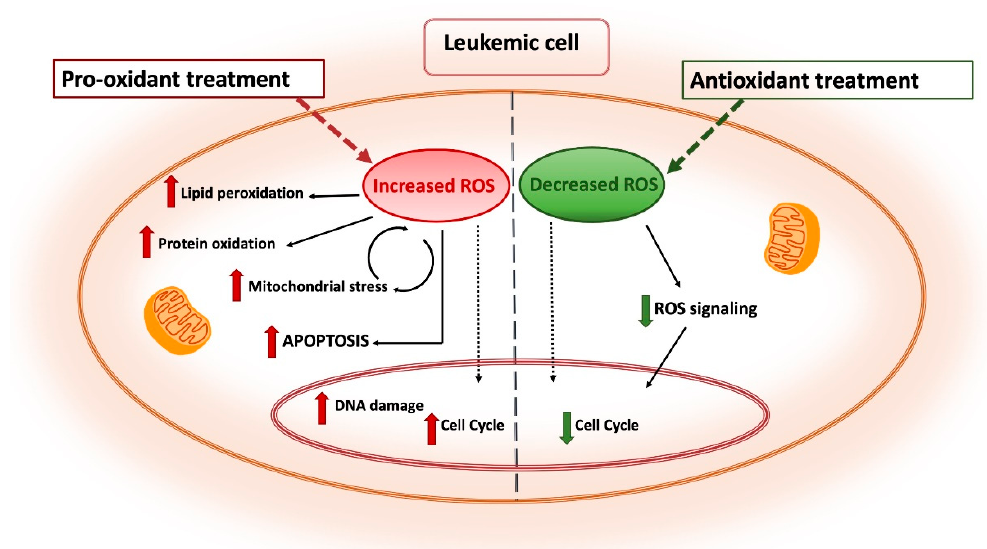
Figure 5. Antioxidant and pro-oxidant strategies as antileukemia therapeutic tools. Pro-oxidant treatments are designed as a strategy to overwhelm the redox adaptation of leukemia cells by inducing oxidative stress incompatible with cellular viability. Enhanced ROS production leads to lipid peroxidation, protein oxidation and DNA damage resulting in increased apoptosis. Conversely, antioxidant treatments are aimed to reduce the leukemogenic potential by tuning down cell proliferation and survival pathways in leukemia cells with high ROS levels. Distinct arrows indicate the involvement of these treatments in different processes and subcellular compartments.